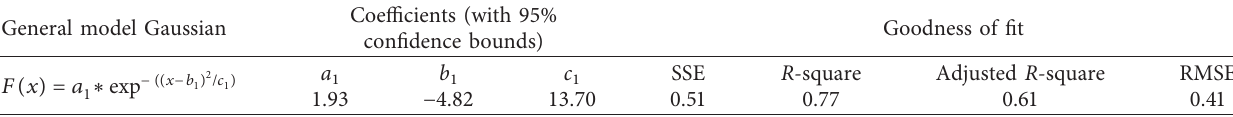
Table 6: Proposed model for the analysis of the accident frequency rate for the clusters.